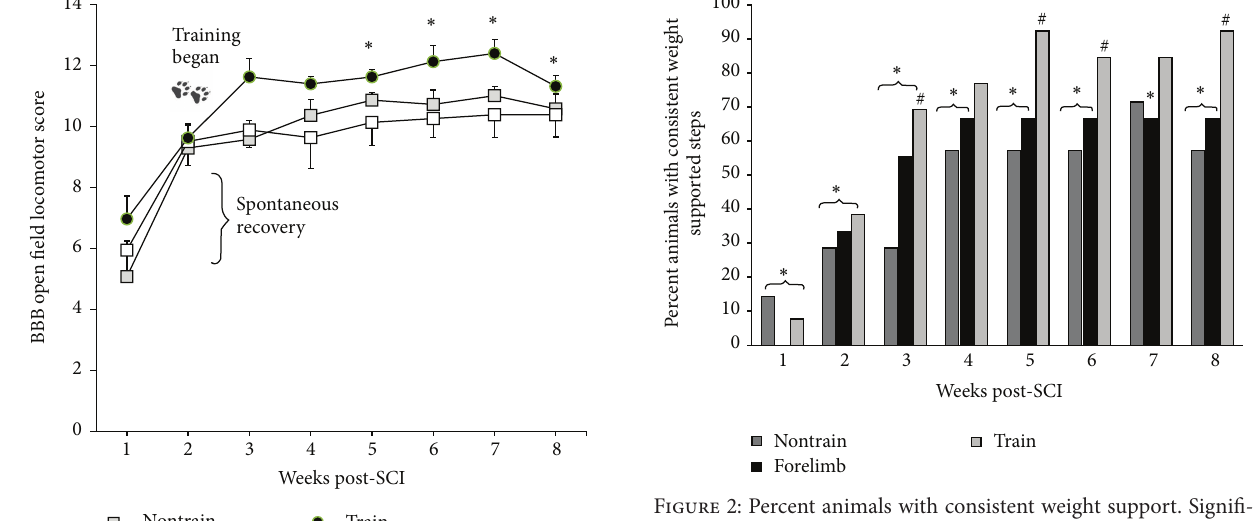
Figure 2: Percent animals with consistent weight support. Signifi- cant differences were found between sham and both the nontrained and forelimb groups ( ∗ ) at weeks 1–8, except week 7, as well as betweenthetrainedandnontrainedgroups(#)atweeks3,5,6,and8. No differences were found between sham and trained animals after week 3 (binomial proportion test: nontrain 𝑛 = 7 ; forelimb 𝑛 = 9 ; train 𝑛 = 13